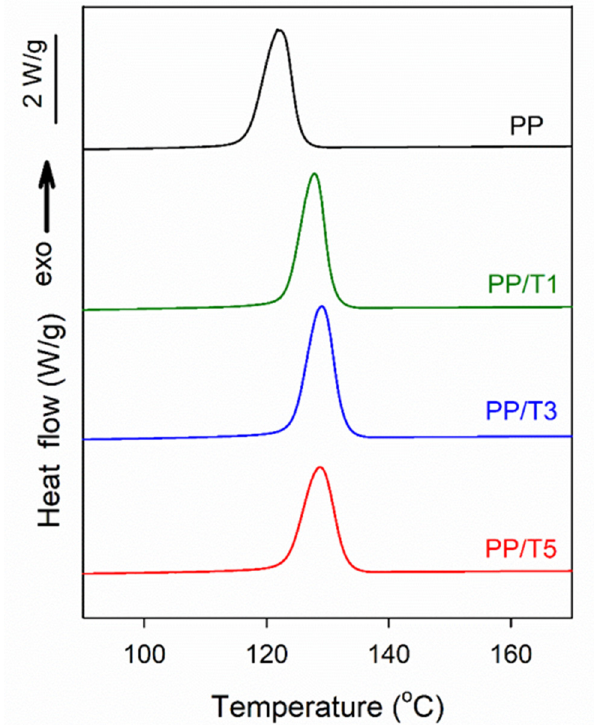
Figure 3. DSC cooling thermograms of PP and PP/T nanocomposites recorded at 10 °C/min.